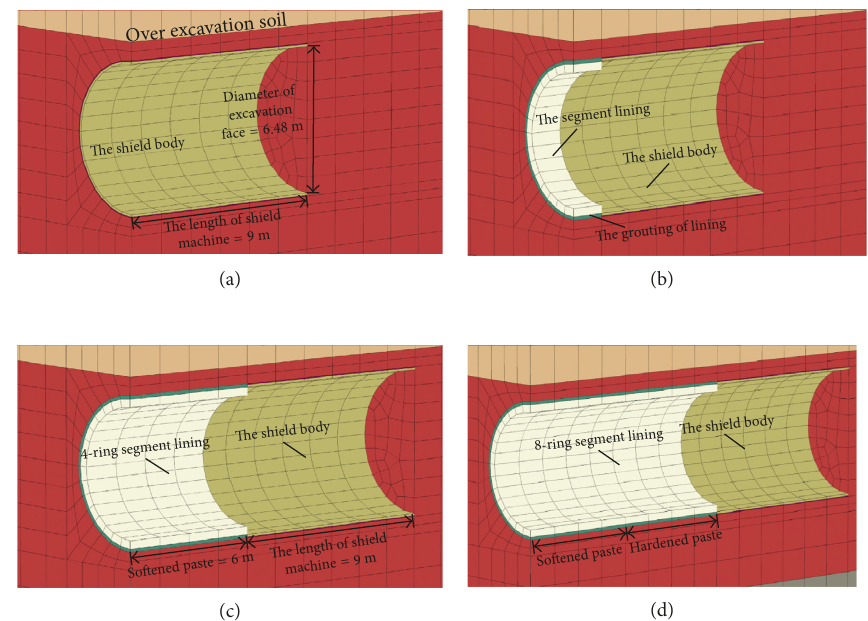
Figure 7: The simulation of the excavation of the shield tunnel. (a) The first step. (b) The second step. (c) The fifth step. (d) The sixth